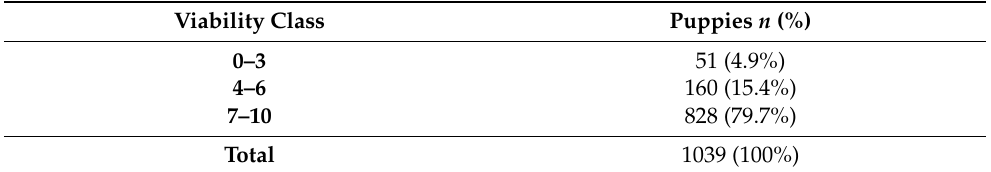
Figure 1. Distribution of the Apgar score (case percentage) in the 1039 live-born puppies.